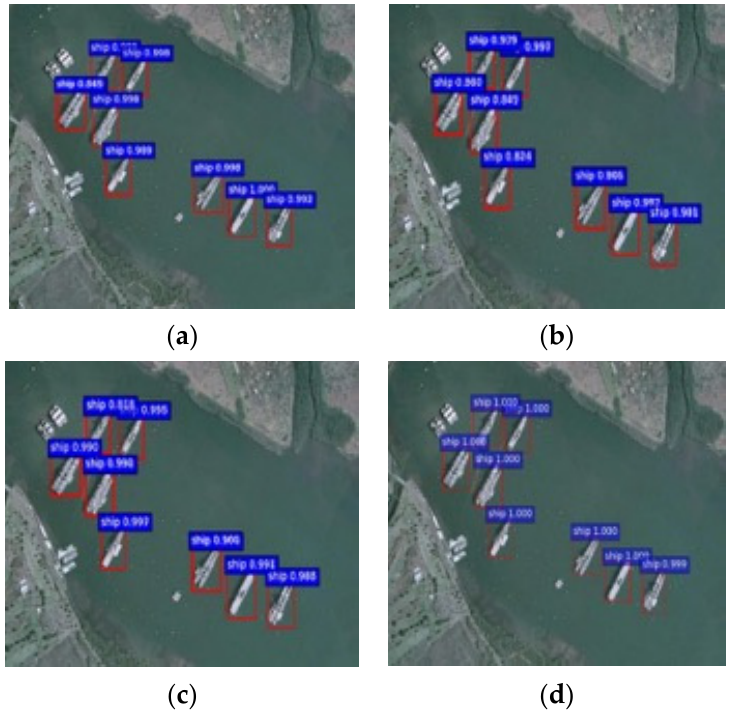
Figure 7. Evaluation of the accuracies of prediction location results (IoU) of different methods: ( a ) Faster R-CNN; ( b ) DRL-Fr; ( c ) MDRL; ( d ) MdrlEcf.